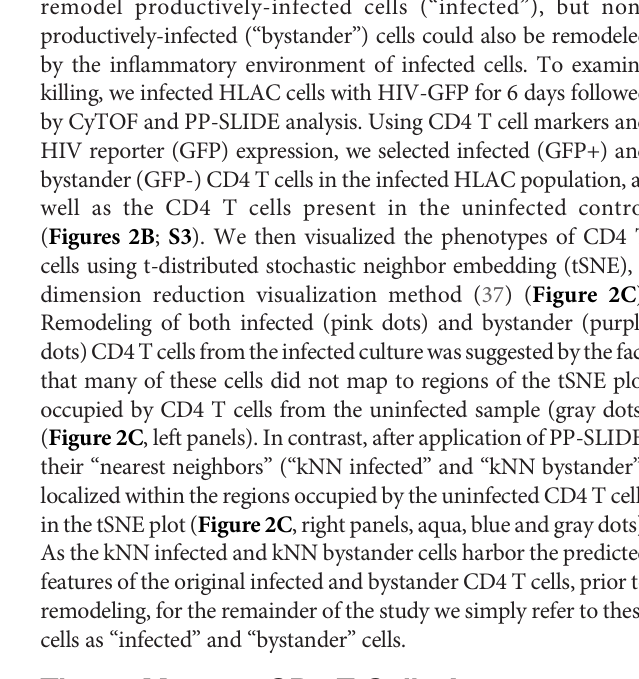
T cell phenotypic subsets ( Table S2 ). Even if some parameters are altered by infection, the high number of CyTOF parameters allows ef fi cient backtracking to the original cell population via PP-SLIDE. As recently described (34), PP-SLIDE uses the 40 CyTOF parameters to match each cell in the infected culture to its “ k- nearest neighbor ” (kNN) cell in the uninfected control population ( Figure2A ,andMaterialsandMethods).HIVinfectionisknownto